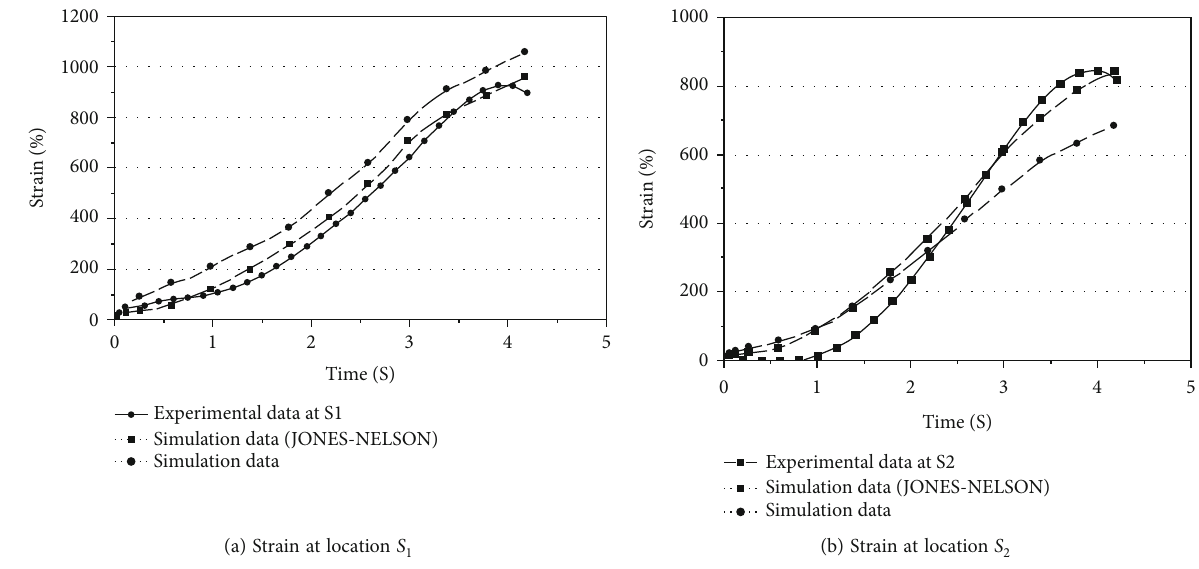
Figure 11: Test strain data and simulation strain data of each strain